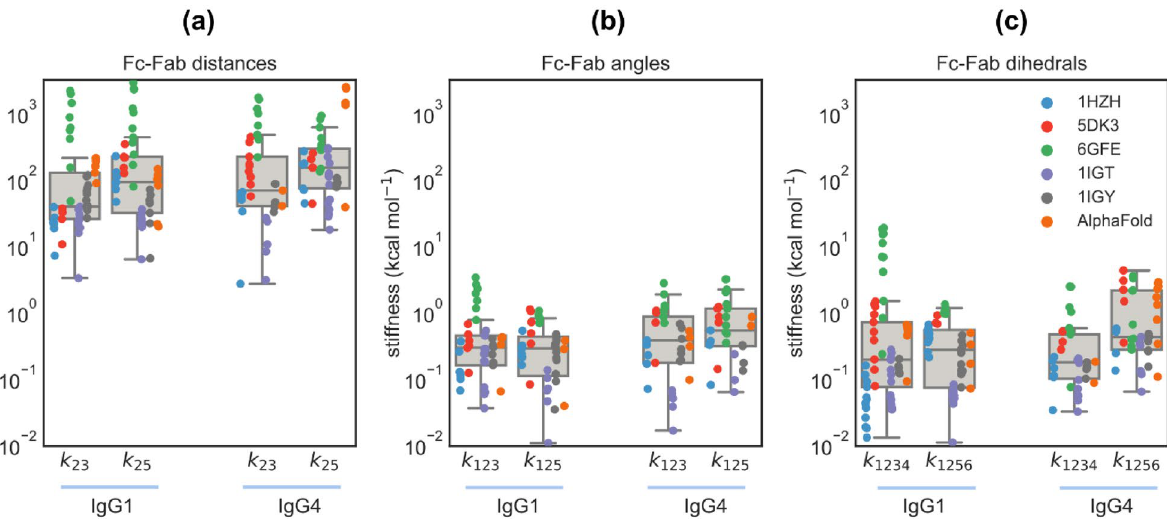
Figure 7. Estimates for stiffnesses parameters associated with ( a ) Fc–Fab distances ( k 23 and k 25 ) and ( b ) Fc–Fab angles ( k 123 and k 125 ) and ( c ) Fc–Fab dihedral angles ( k 1234 and k 1256 ), grouped by antibody isotype,